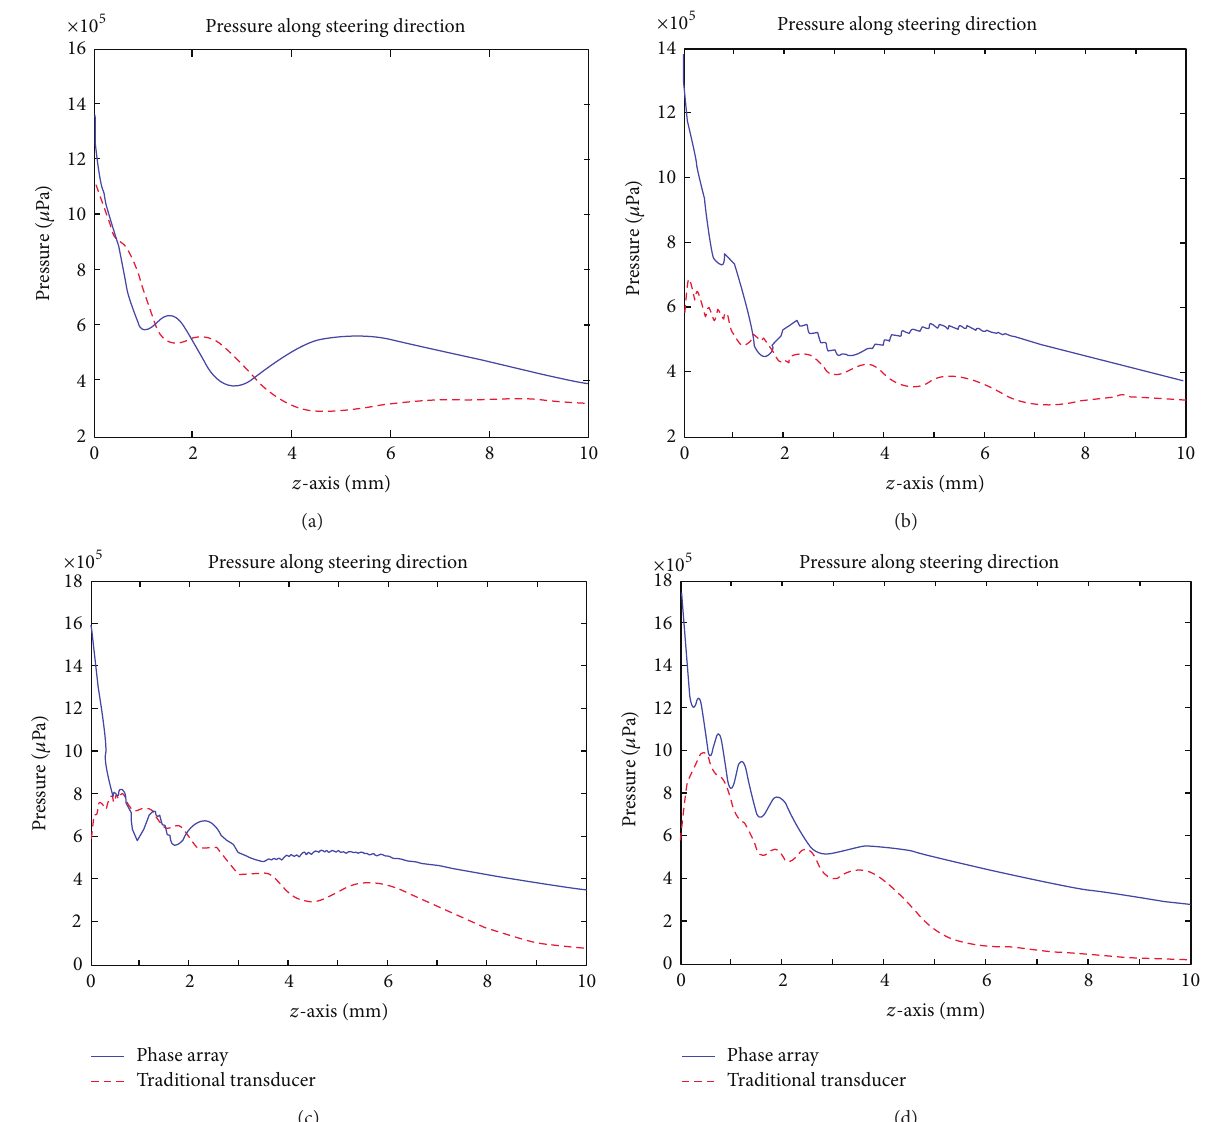
Figure 11: Comparison of the pressure by phased array and traditional transducer along the